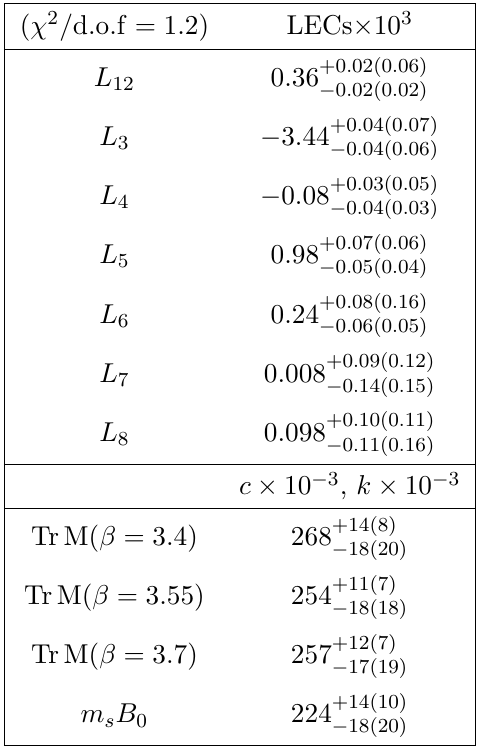
Table 10 . Values of the parameters obtained in Fit IV. The errors can be interpreted in terms of probability. The central value represents the median, the (cid:12)rst upper and down indices gives the 68% CI, while the sum of the absolute values of the two upper (down) indices provides the upper (down) limits of the 95% CI.